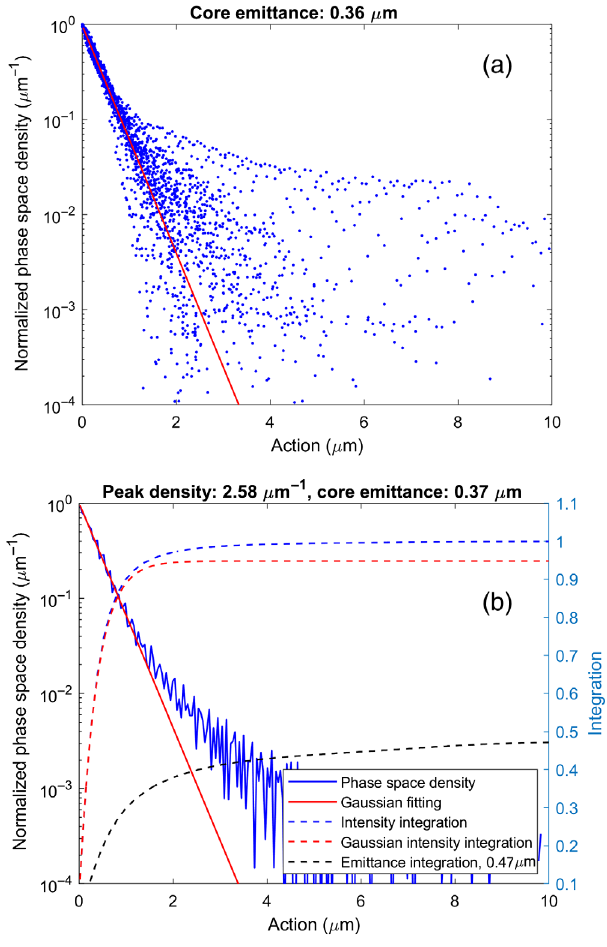
simulations.FIG. 9. Gaussian core analysis of 250-pC beam phase